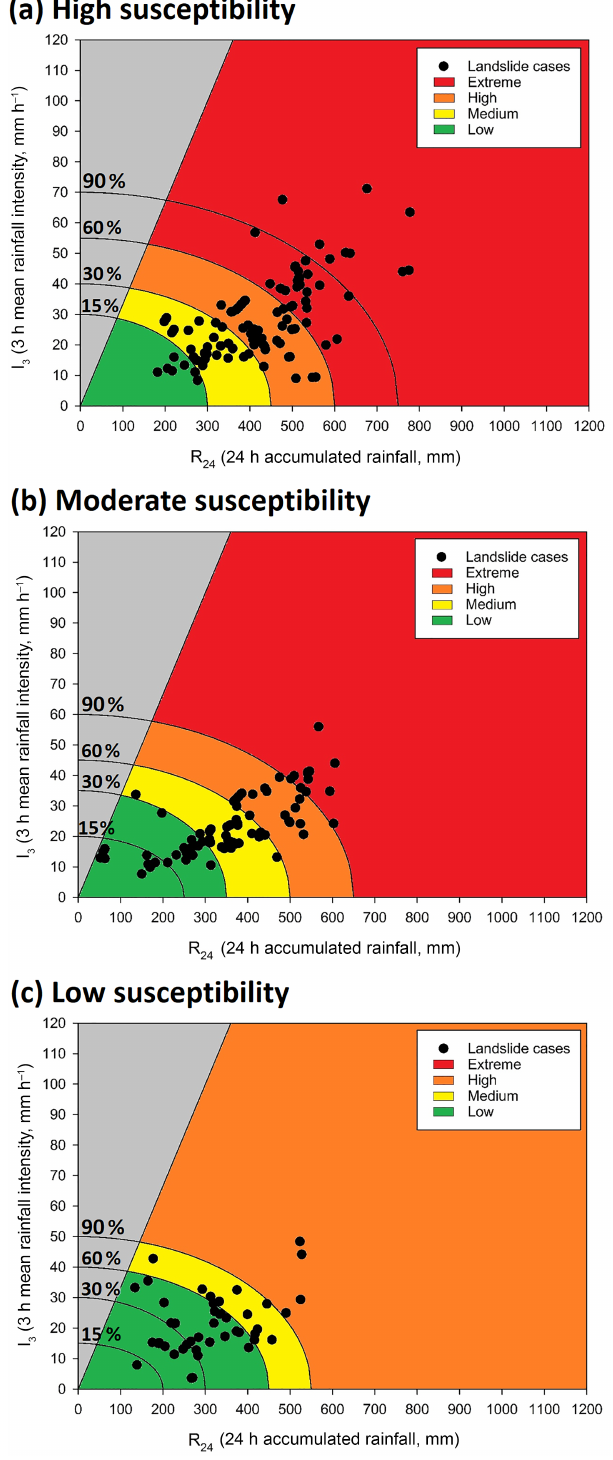
Figure 6. I 3 – R 24 rainfall thresholds and alert of (a) high- susceptibility slope units (b) moderate susceptibility slope units and (c) low-susceptibility slope units for southern